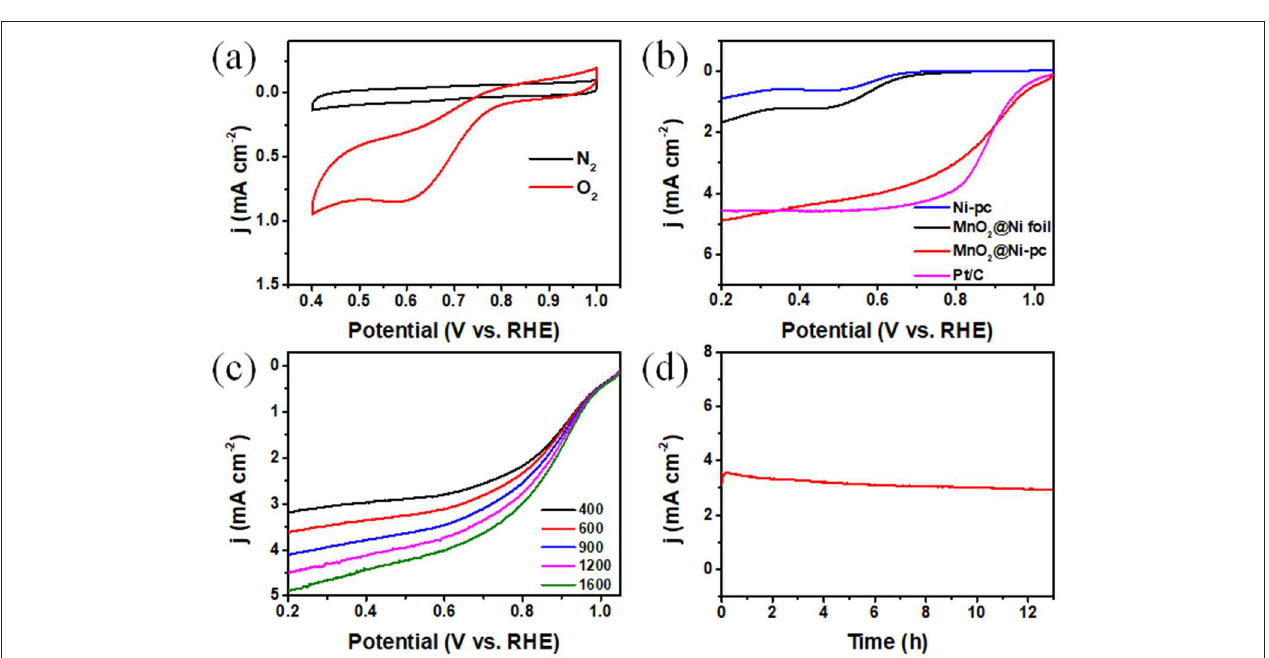
FIGURE 3 | (a) CV curves of MnO 2 @Ni-pc in N 2 and O 2 -saturated 0.1M KOH; (b) LSV curves of various materials at 1,600 rpm with a sweep rate of 10mV s − 1 in O 2 -saturated 0.1M koh; (c) LSV curves of MnO 2 @Ni-pc at different rotating speeds; (d) I-t curve of MnO 2 @Ni-pc tested at 0.57V vs. RHE in O 2 -saturated 0.1M KOH. suggesting a great enhancement of ORR kinetics compared transfer number (n) per O 2 of MnO 2 @Ni-pc according to the to MnO 2 (3.1, 2.7, and 2.3 for pure α -, β -, and γ -MnO 2 , K-L equation ( Figure S5 , see Supporting Information for more respectively) reported before (Wu et al., 2012; Han et al., details) is ∼ 3.4 within the potential ranging from 0.2 to 0.5 V,